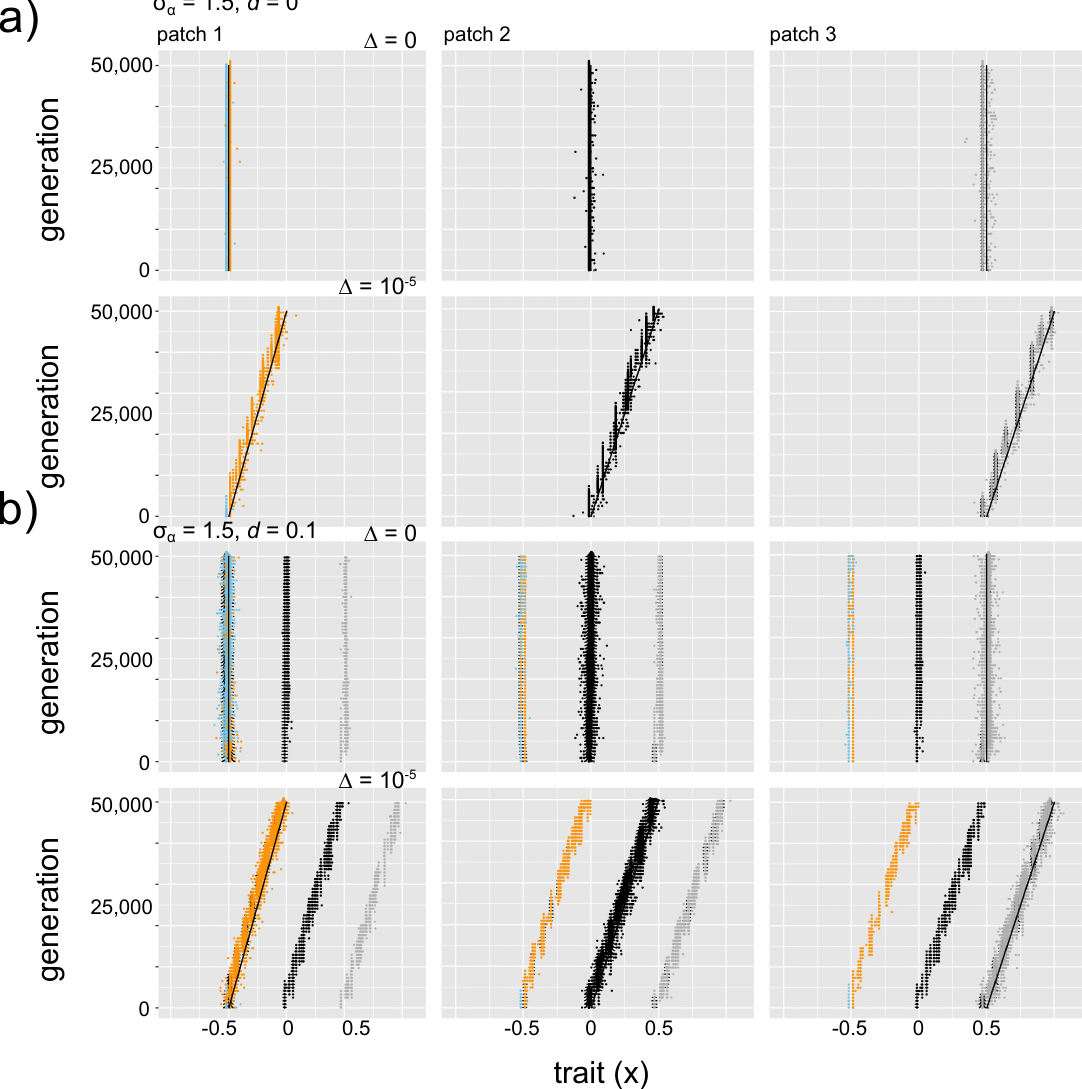
Figure 5. Impacts of competition strength ( σ α = 1.5), dispersal rate, and speed of environmental change for community trait distributions over time. Plots give phenotypic distributions ( x axis is trait value, height of density plots is relative abundance of individuals with that trait value, y axis is time; the time series are thinned to show every 800 generations) and the solid black line in each plot indicates the local optimum trait value over time. ( a ) When niche width is high ( σ α = 1.5), in the absence of dispersal ( d = 0) fewer species exist because individuals with similar trait values face strong competition. These species can adapt to slow environmental change (upper row: ∆ = 0; lower row: ∆ = 10 − 5 ) but retain little intraspecific diversity. ( b ) Dispersal ( d = 0.1; σ α = 1.5; upper row: ∆ = 0; lower row: ∆ = 10 − 5 ) not only that they can persist in other patches but at lower population sizes), it also increases the amount